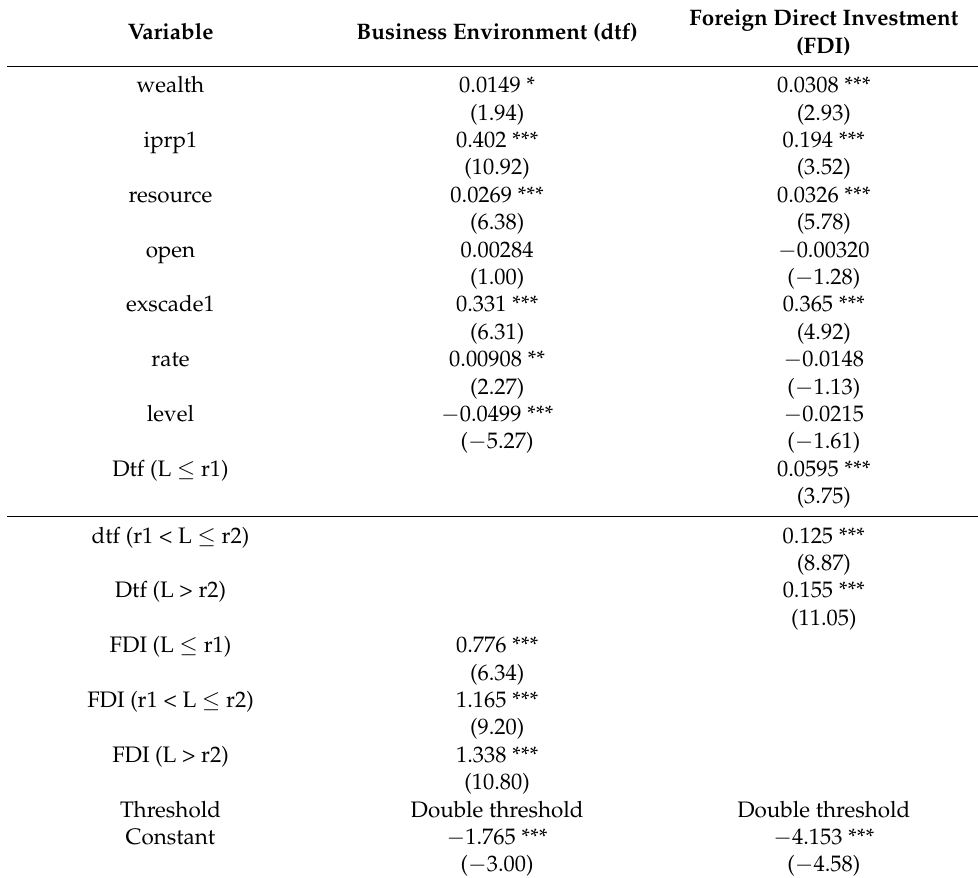
Table 7. Estimation results of threshold